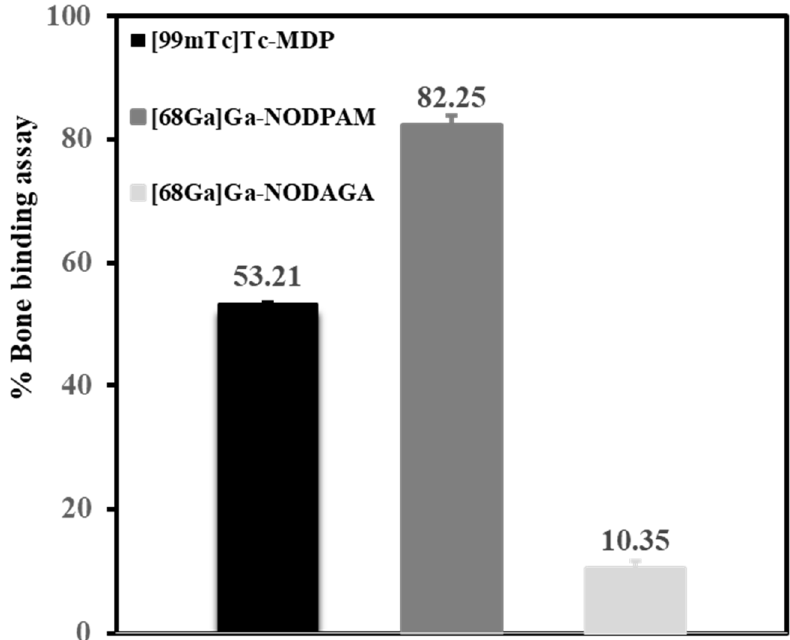
Figure 15. In vitro % bone binding assay for [ 99m Tc]Tc-MDP, [ 68 Ga]Ga-NODPAM, and [ 68 Ga]Ga-NODAGA.